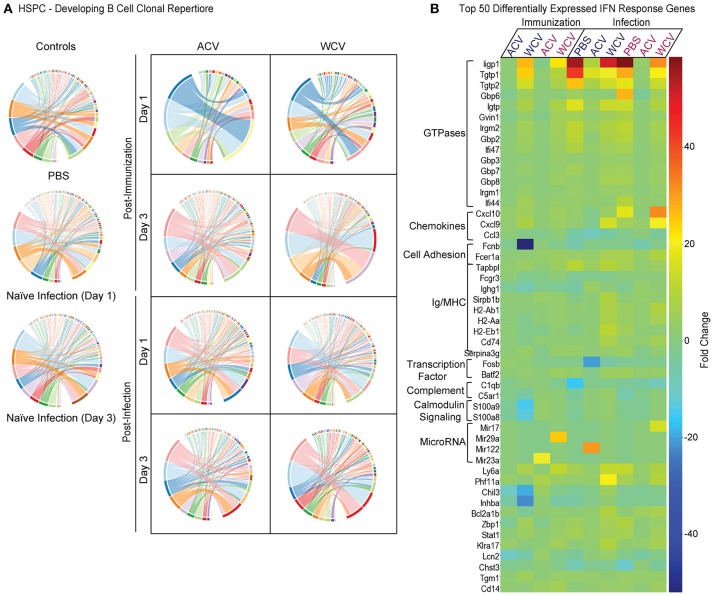
Vaccine content drives the transcriptional landscape of HSPCs. (A) Pairwise overlap circos plots of HSPC B cell clonal repertoires (n = 6mice/group) were prepared using MiXCR software. Count, frequency and diversity panels correspond to the read count, frequency (both non-symmetric) and the total number of clonotypes that are shared between samples. Pairwise overlaps are stacked, i.e., segment arc length is not equal to sample size. (B) A heatmap was prepared to represent the top 50 differentially expressed genes downstream of IFNα, β, and/or γ across all immunization and infection groups. Day 1 for immunization and infection is shown below the dark blue text, while day 3 is shown below the magenta text. Gene sets for the heatmap were prepared using IPA's Upstream Regulator analytic tool. RNA was pooled from 2 mice for each sample n.